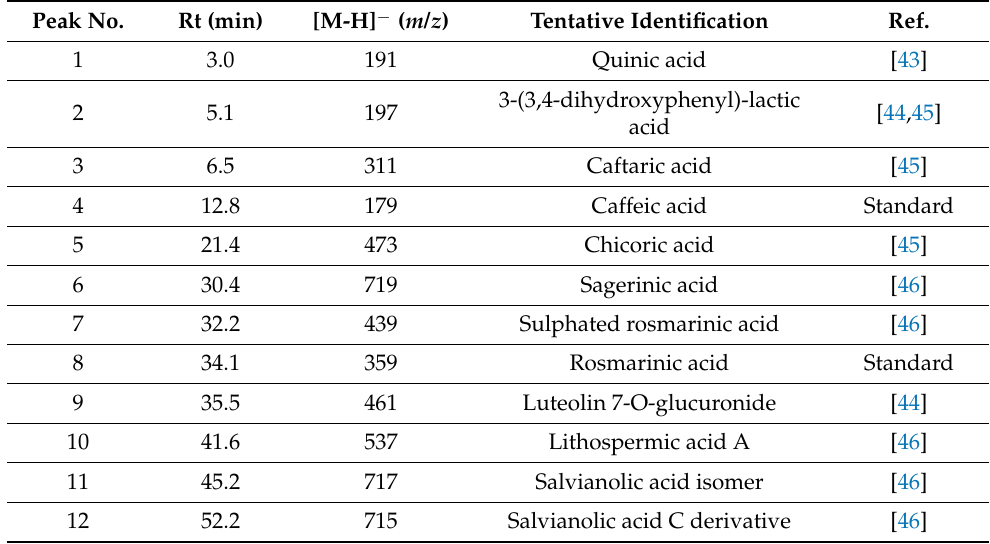
Table 1. Phenolic compounds tentatively identified in M. officinalis extract by LC-MS in negative ionization mode. Peak